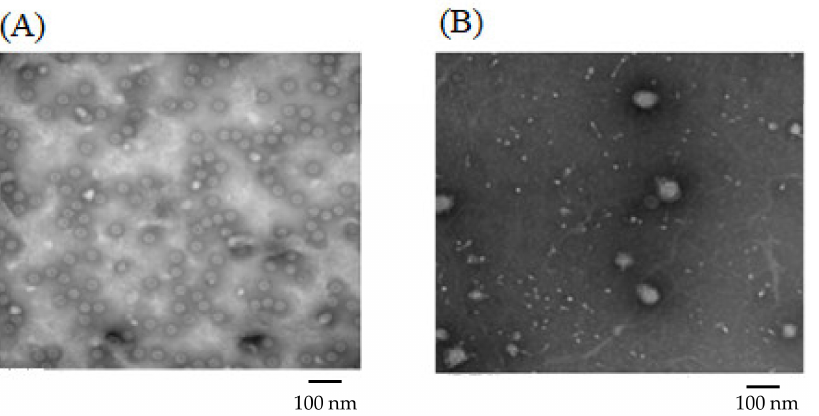
Figure 2. ( A , B ). Scanning Electron Microscope Image of Formulations 1 and 2. ( A ) Formulation 1